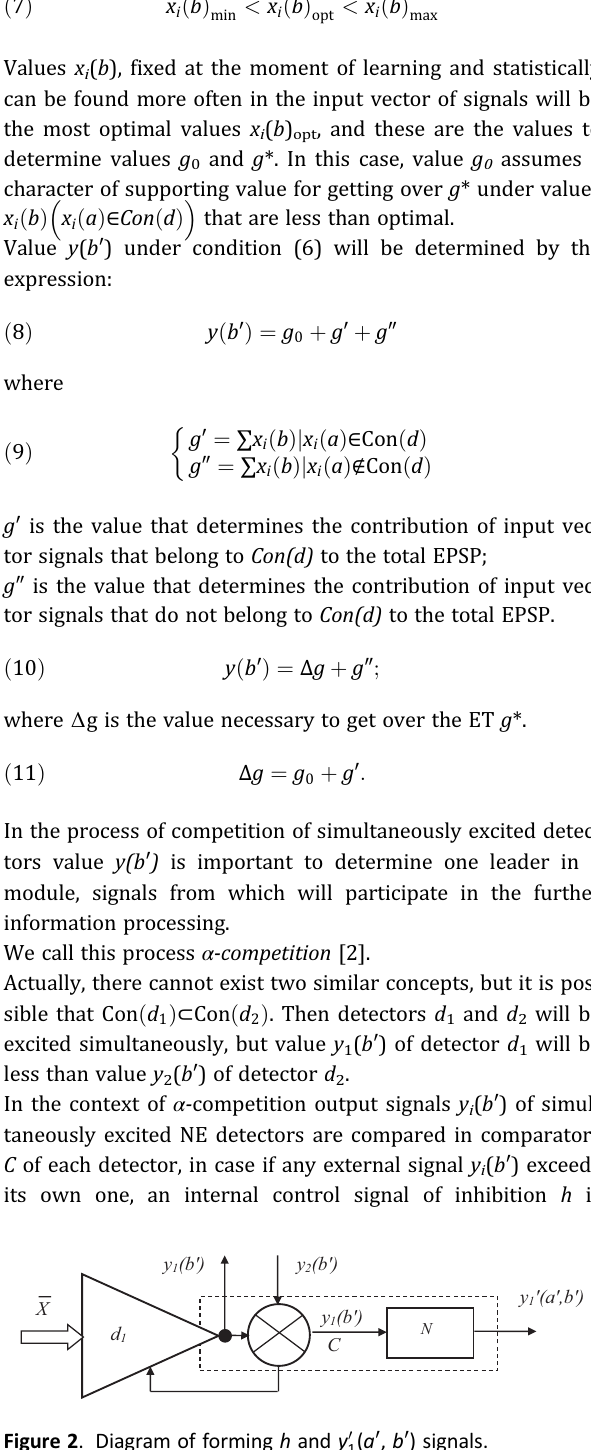
Figure 1 . Power function w 0 i . Figure 2 . Diagram of forming h and y 0